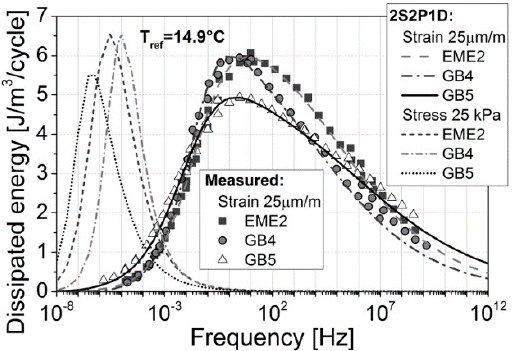
Figure 14. The points of the binder Cole-Cole curve are shifted of the E value to the left along the E axis. An Figure 13. Viscous energy dissipation curves for each mixture – 00 binder 1 intermediate Cole-Cole curve is then built with homothetic Strain and stress control modes. transformation of the shifted binder points. The points of this intermediate curve are then shifted of the E value 00 mix to the right along the E axis in order to attain the Cole-Cole 1 curve of the mixture. The points of the mixture Cole-Cole curve are associated to the same test temperature and to a frequency equal to 10 -α times the frequency of the binder curve points.